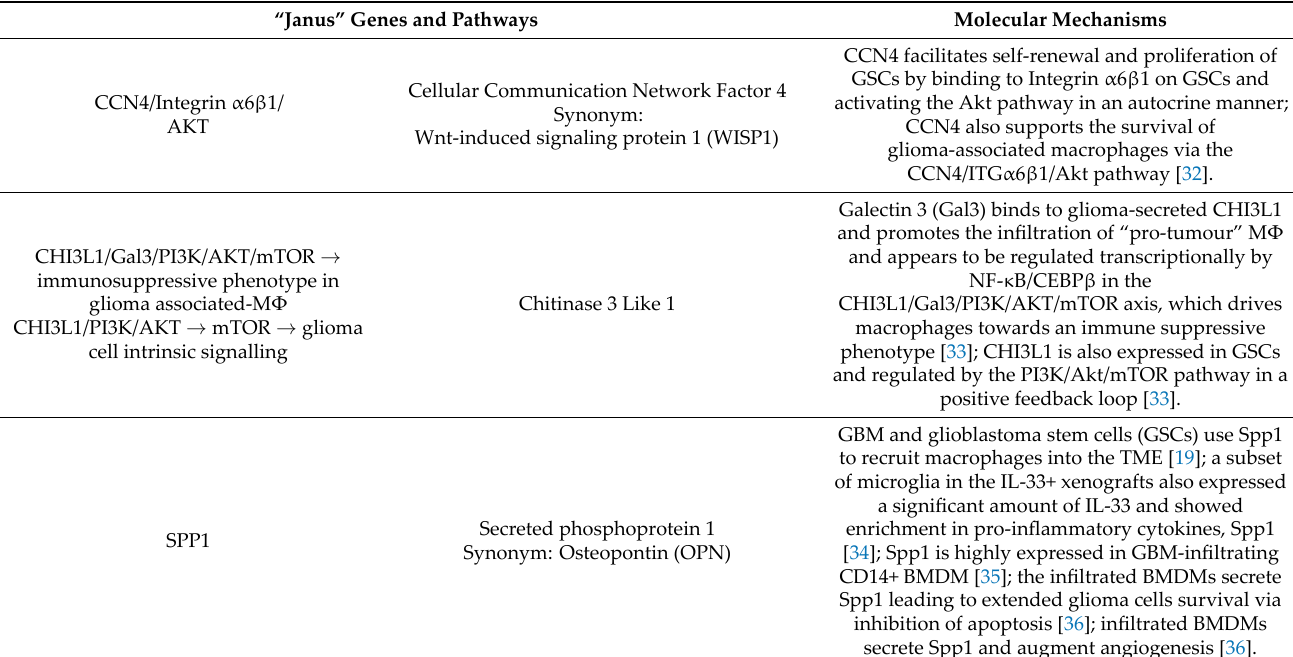
Table 1. Synergistic (“Janus”) genes and pathways that act in both glioblastoma cells and microglia/ macrophages supporting glioblastoma progression in a complementary fashion (please also see